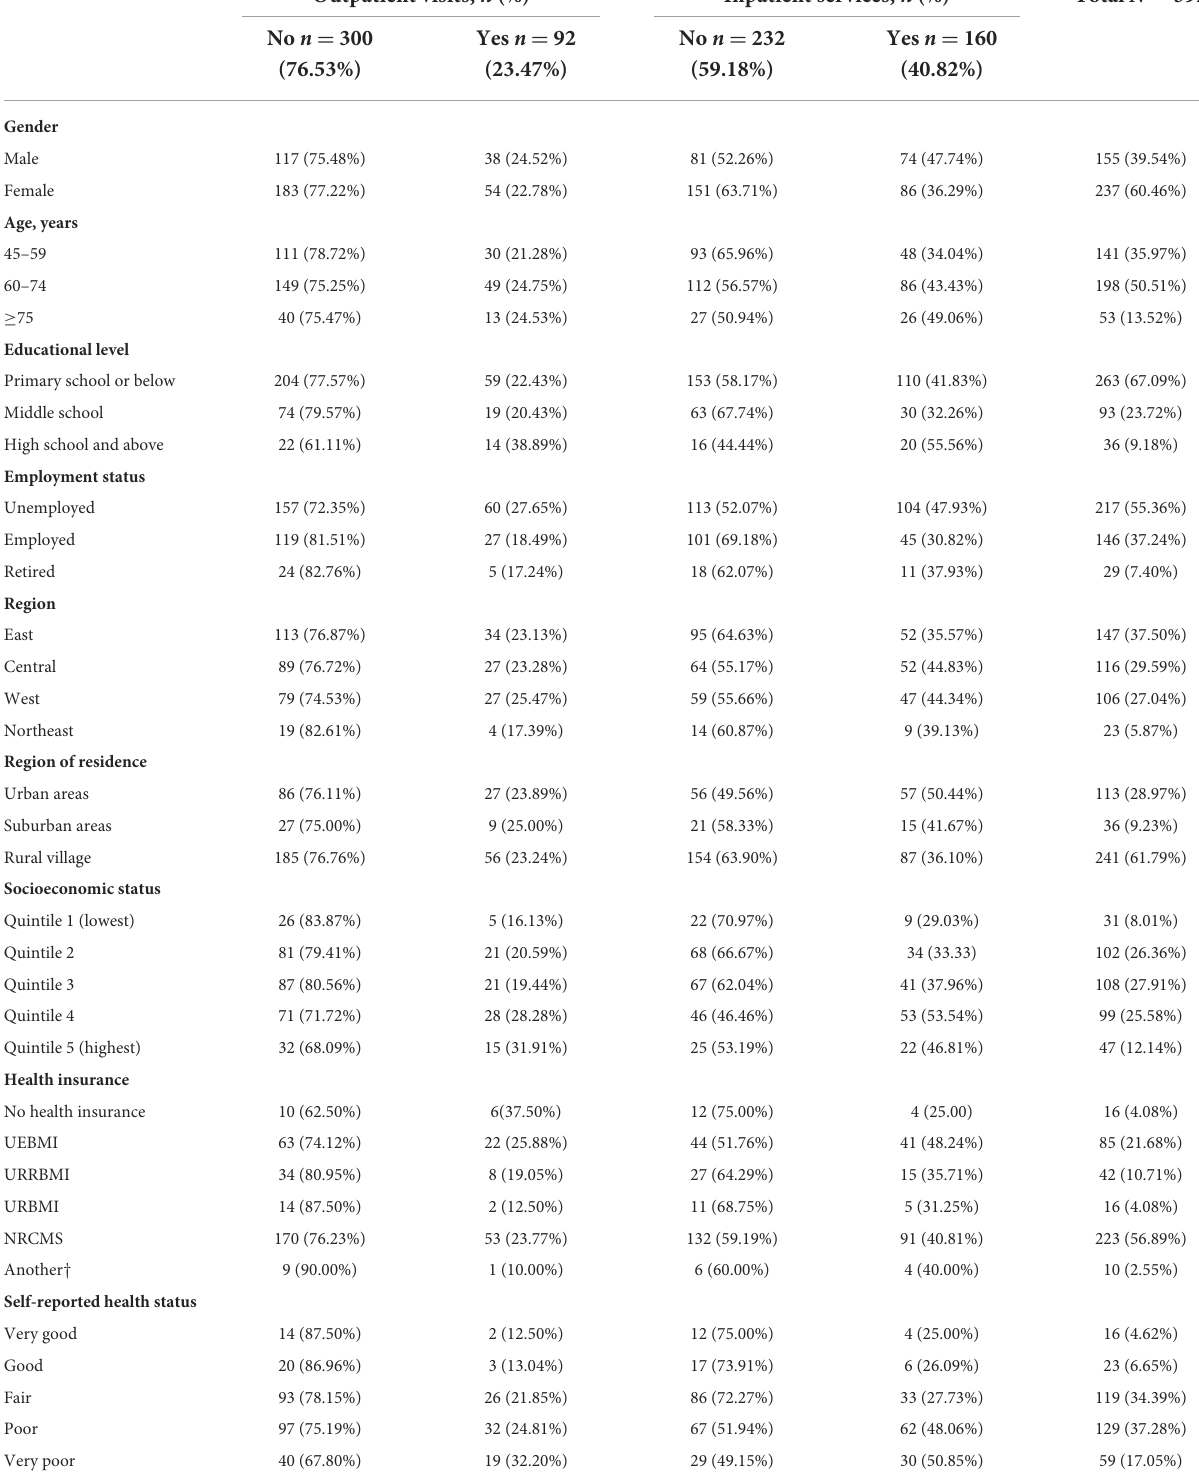
TABLE 1 Descriptive characteristics of cancer